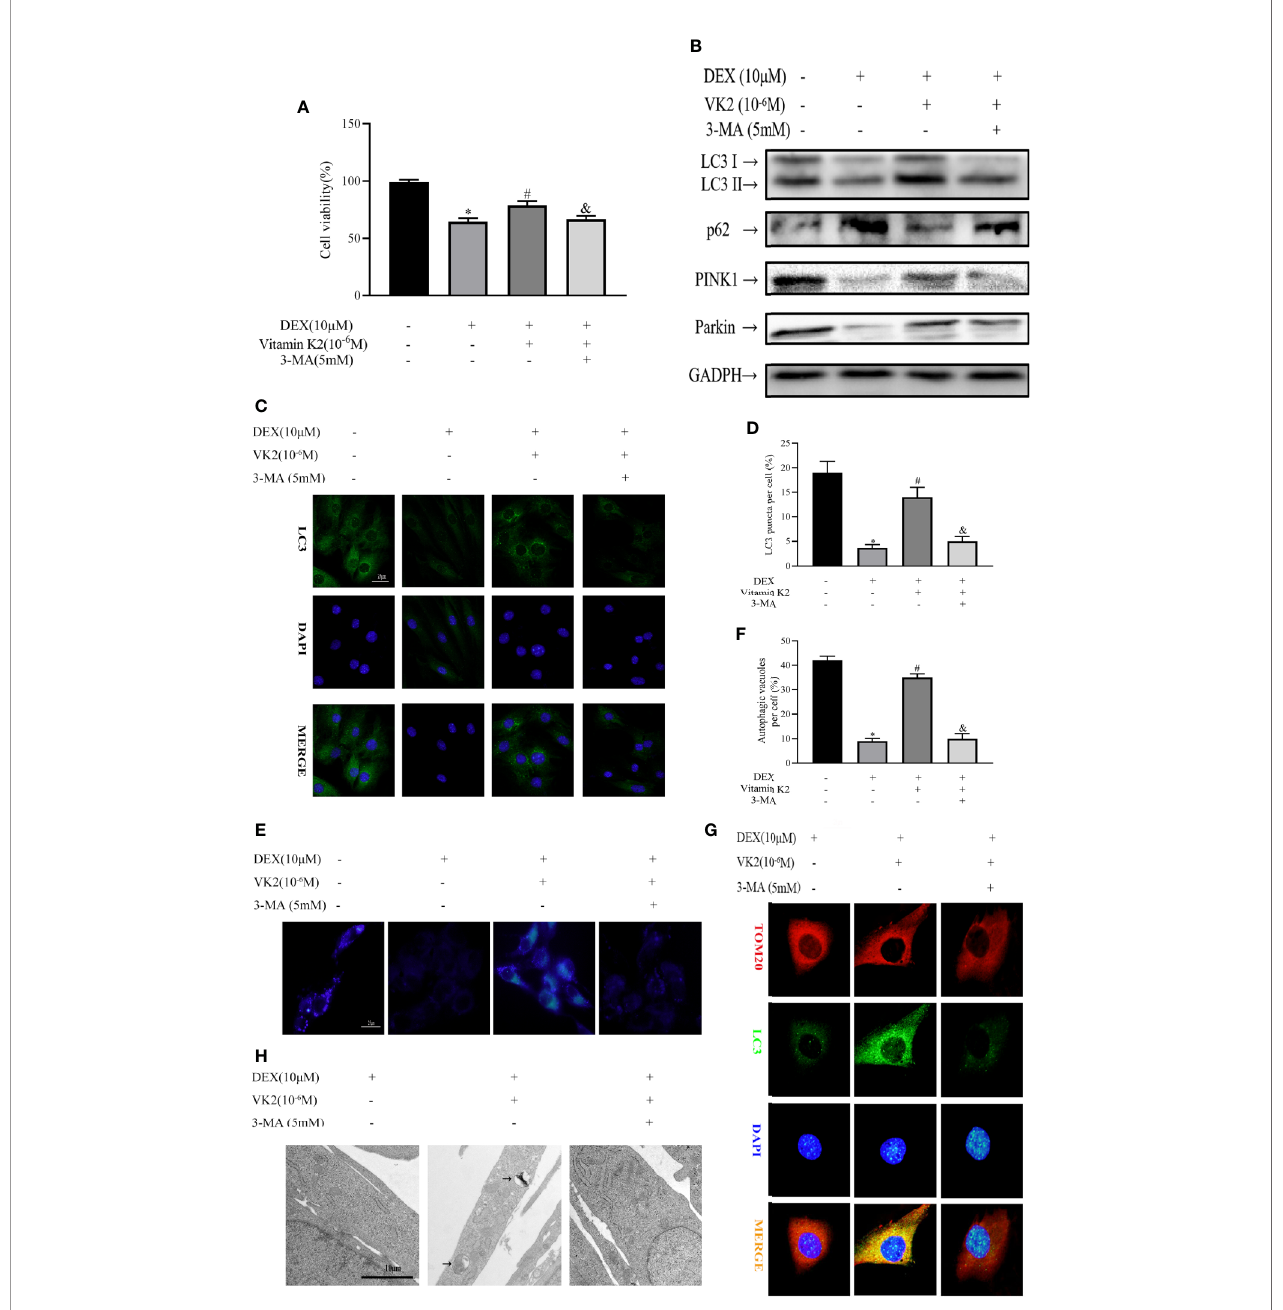
FIGURE 3 | VK2 alleviates inhibitory effects of Dex on osteoblast autophagy and mitophagy. Primary osteoblasts were initially treated with 10 m M Dex for 24 h, then 10 − 6 M VK2 without/with 5 mM 3-MA was added into the culture medium for another 48 h. (A) Effects of Vitamin K2 on the growth of osteoblasts under the inhibition of Dexamethasone with/without 3-MA, as measured by CCK8 assays; (B) Western blot results showed the alteration of mitophagy-related protein expression levels of the above indicators; (C, D) Representative images and quanti fi ed analysis of immuno fl uorescence staining of LC3 in osteoblasts; (E, F) MDC staining was used to con fi rm the alteration of the abundance of autophagic vacuoles in aforementioned group; (G) Representative images of immuno fl uorescence double staining of LC3 and Tom20 in osteoblasts; (H) Mitophagosomes were detected by transmission electron microscopy (×10,000) in osteoblasts. (Black arrow: mitophagosome). Data was expressed as mean ± SEM, n = 5; *p < 0.01 vs. control group, # p < 0.01 vs. DEX group, & p < 0.01 vs. DEX+VK2